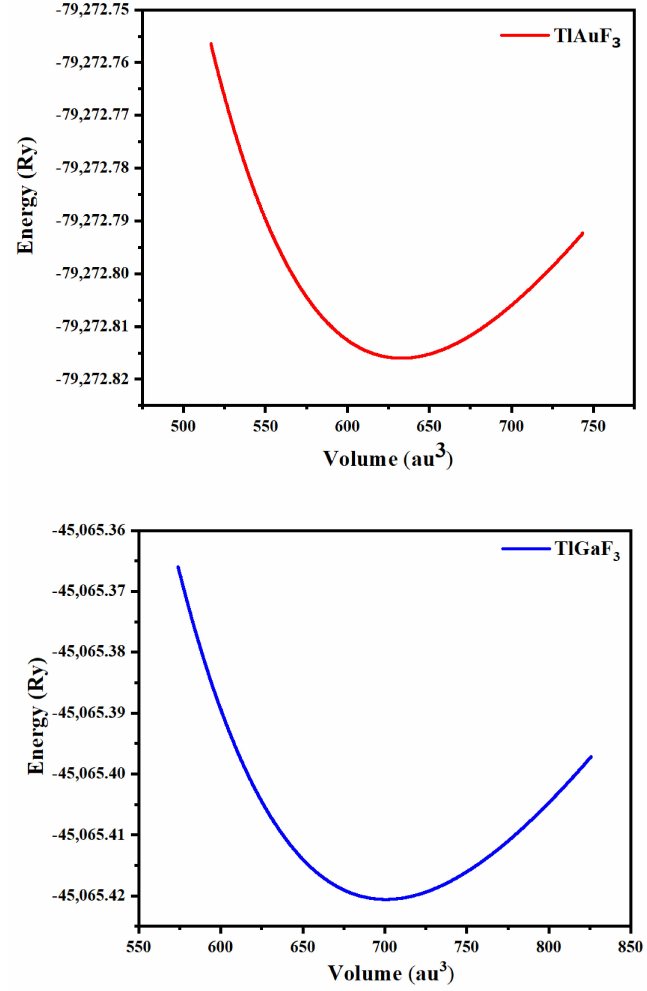
Figure 2. Representing TlMF 3 (M = Au, Ga) dependence of the optimized energy against volume. The right value of RMT was chosen for this inquiry to ensure that no charges escaped from the whole and core energy. RMT values for Tl, Au, and Ga were 2.02, 2.50, and 2.52, respectively, while RMT values for F in TlAuF 3 and TlGaF 3 were 2.02 and 2.09, respectively. Due to the muffin tin sphere’s 1500 K-points and 13.0 Gmax, the waveform was overextended in harmonics up to lmax = 10. The energy difference between the valence and core bands was 6.0